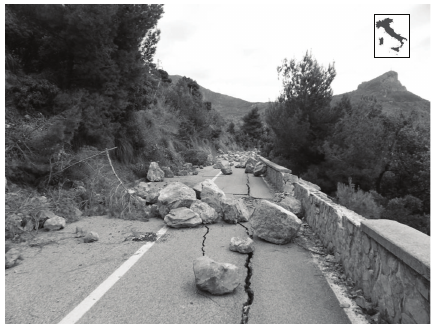
Figure 1: Rockfall on SS18 road located in the Rasi